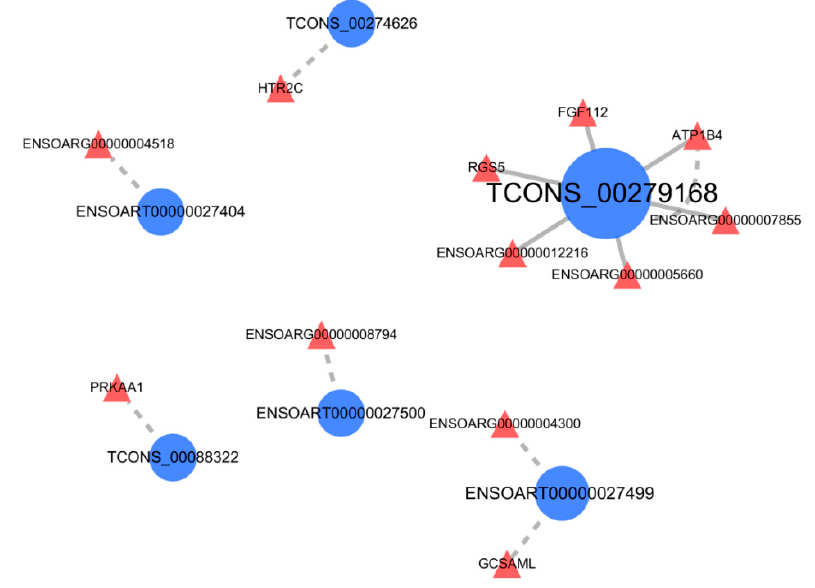
Figure 6. The result of the interaction relationship between differentially expressed lncRNAs and their corresponding differentially expressed mRNAs. Blue and red, circles, and triangles represent lncRNAs and mRNAs. The dotted line represents the co-location relationship, and the solid line represents the co-expression relationship. Furthermore, bigger circles indicate that these lncRNAs have stronger connections with the differentially expressed mRNAs.